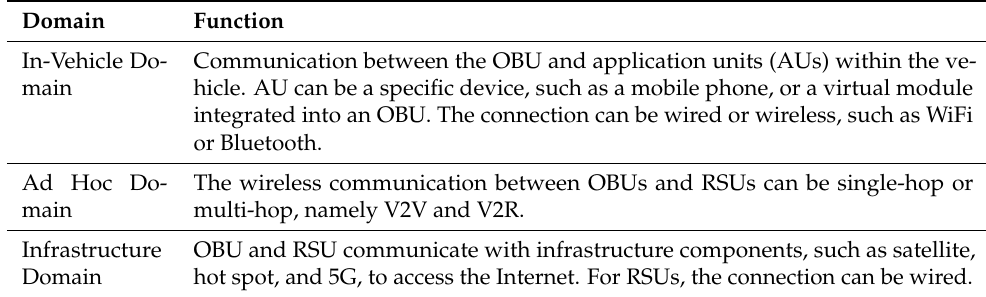
Figure 3. Evolution history of the VANET. Table 1. Three domains of